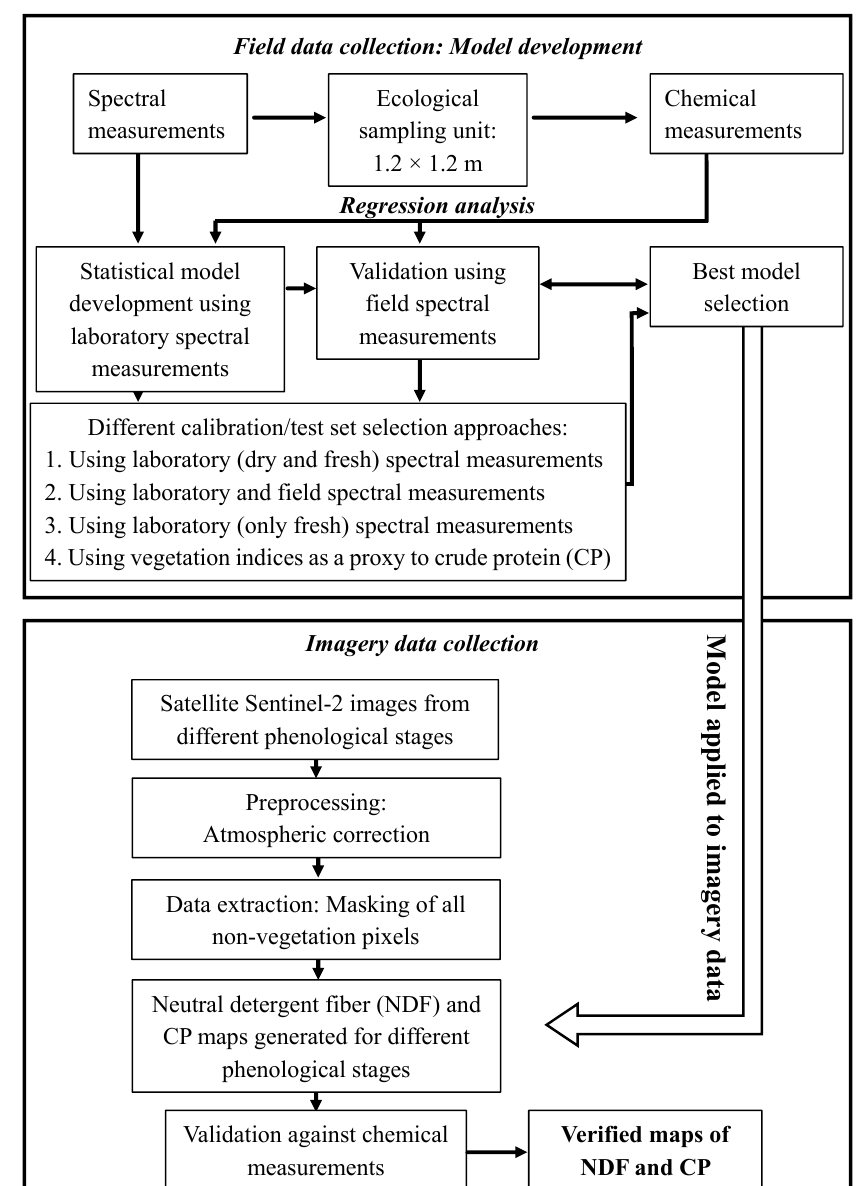
Figure 1. Flow chart of the study’s general methodology.